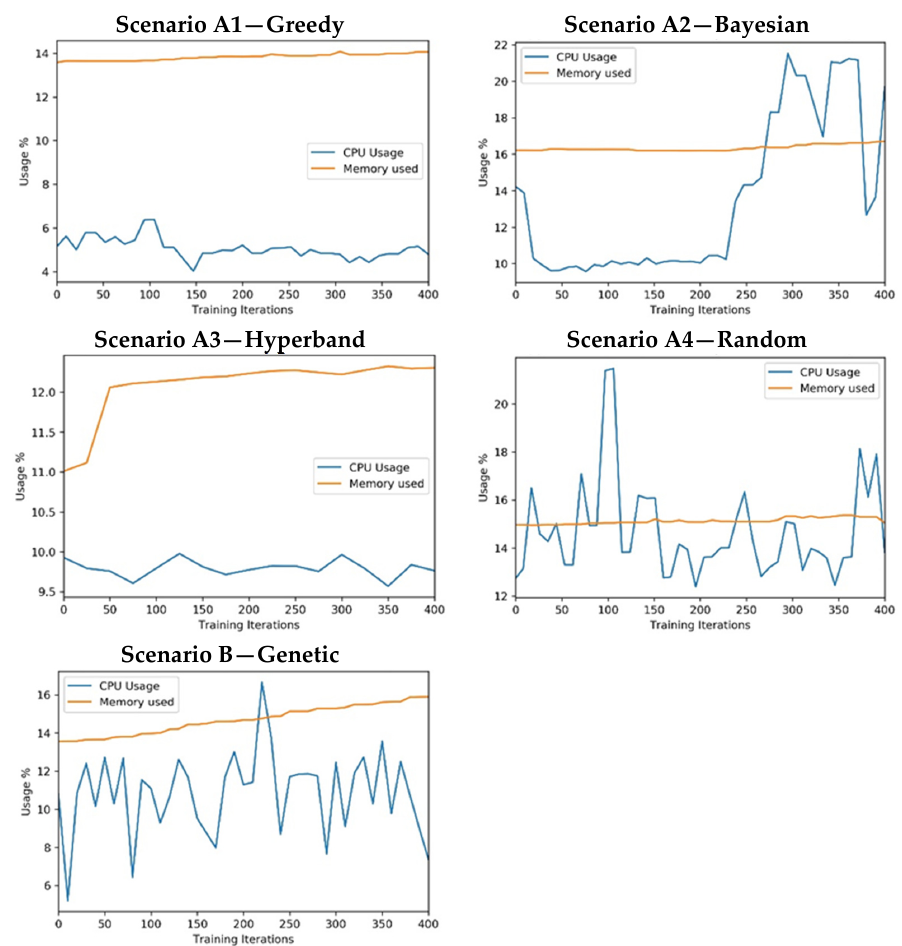
Figure 12. Experiment’s measure: CPU consumption.